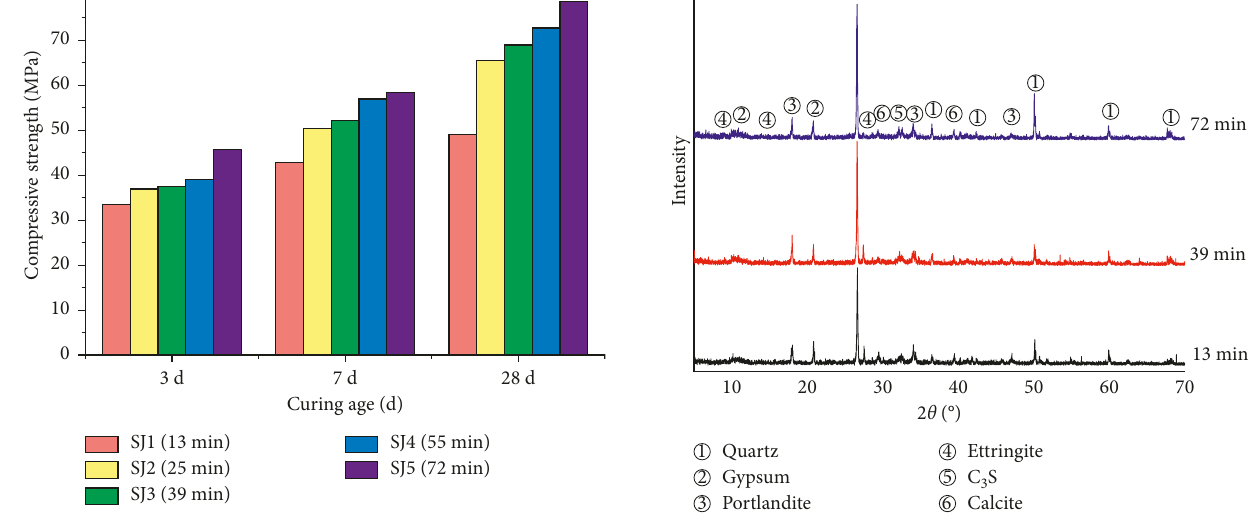
Figure 7: XRD patterns of the mortars with different grinding times at 3d age.